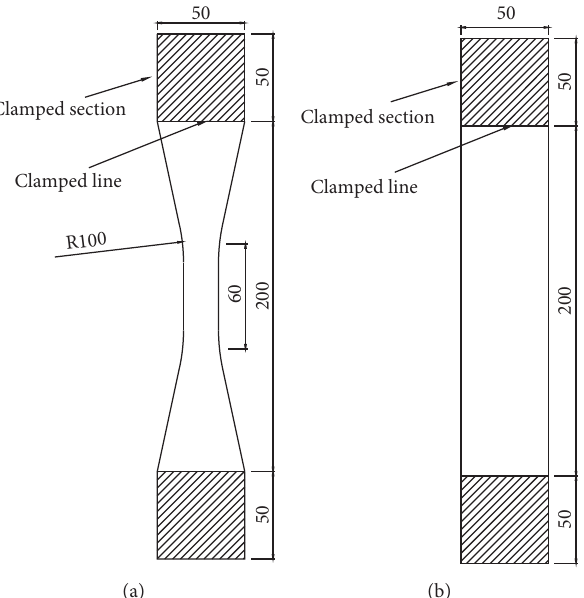
Figure 1: Dimensions of the PVC-coated fabric specimens (units: mm). (a) Dumbbell shape. (b) Strip